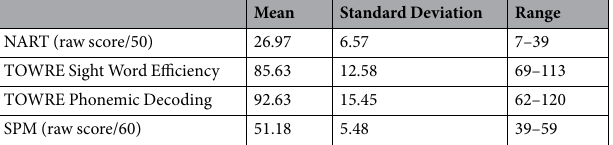
Table 1. Psychometric statistics for the entire sample. Standard scores ( M = 100, SD = 15) are shown